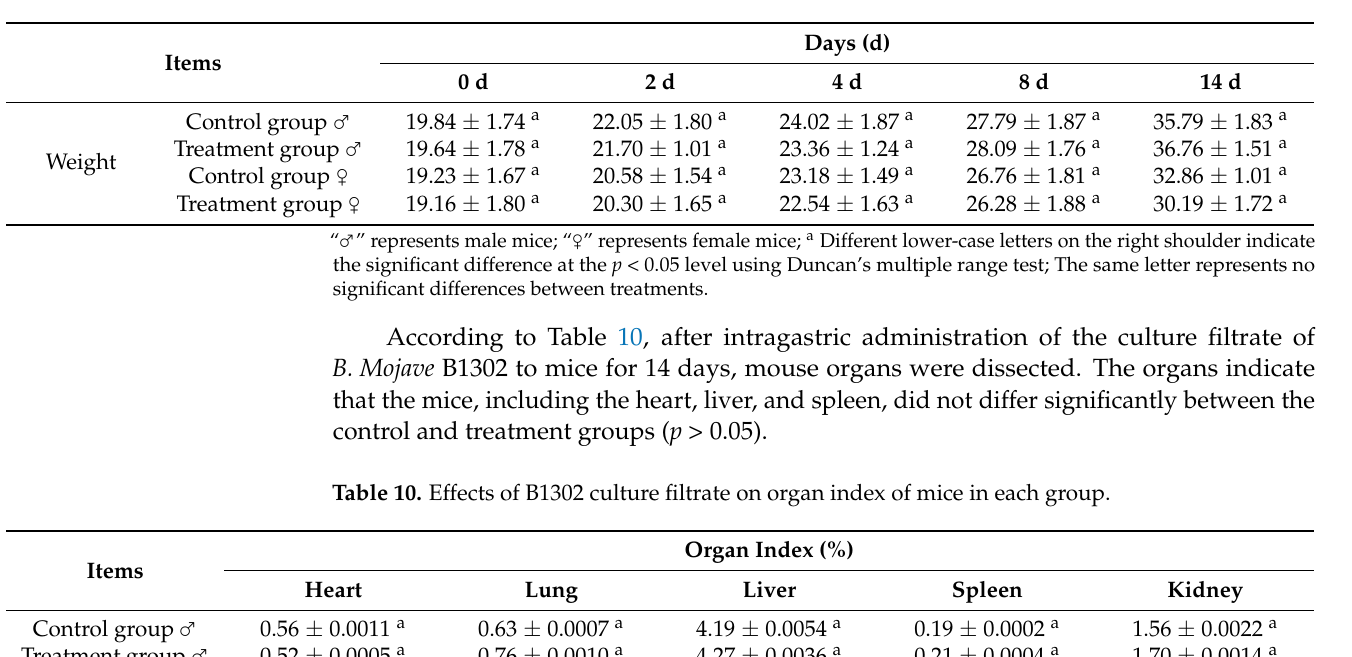
Table 9. Effects of B1302 culture filtrate on the weight of mice in each group.